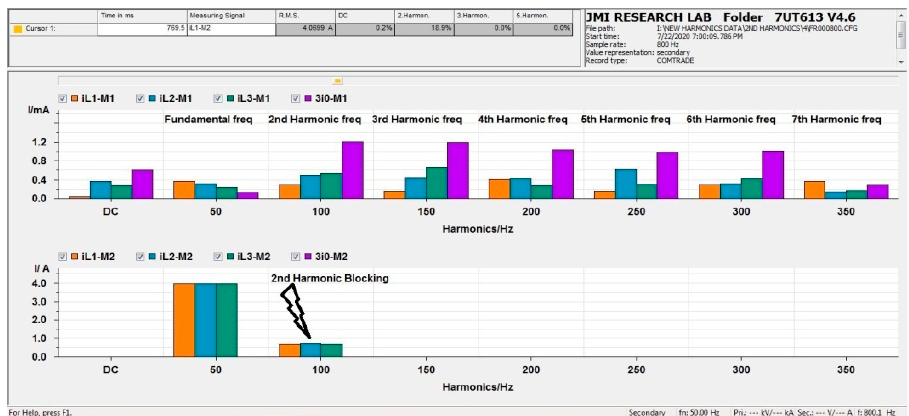
Figure 20. 2nd HB at 5000 mA Rated current & 15% of Inrush current condition.